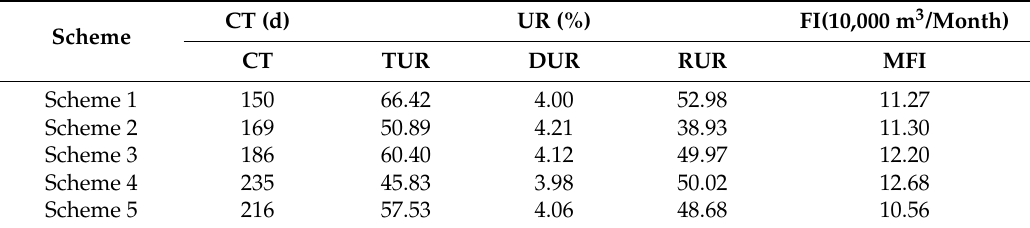
Table 3. Simulation results of schemes in the core wall at Elevation 2740 m to Elevation 2759 m.